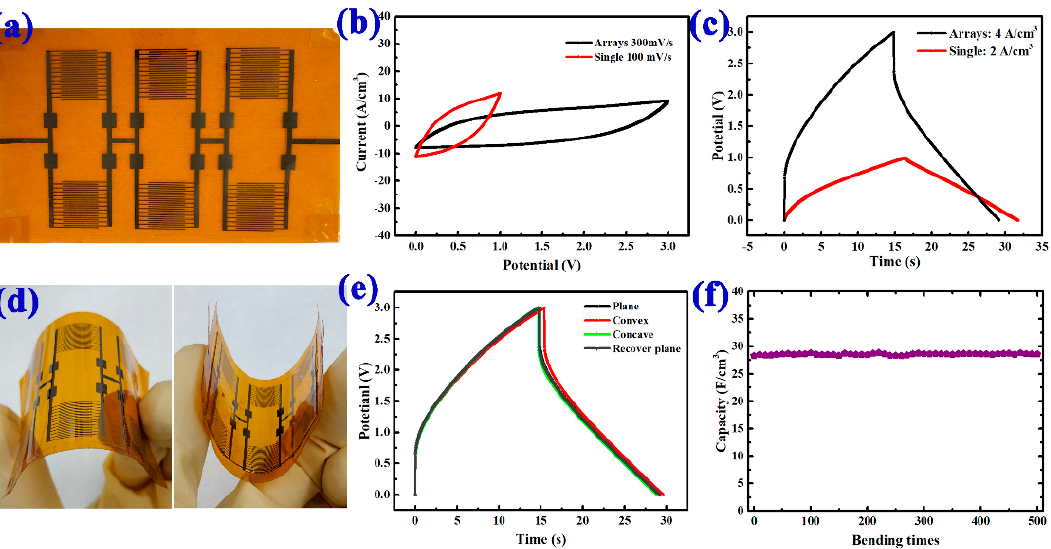
Figure 5. The integrated MSCs system based on six individual devices: ( a ) device position on the substrate; ( b ) CV curves of one MSC and an integrated arrays of six MSCs at scan rates of 100 mV/s and 300 mV/s, respectively; ( c ) galvanostatic CD curves of an array system of one MSC and six MSCs at the currents of 2 A/cm 3 and 4 A/cm 3 , respectively; ( d ) photos of an integrated MSCs system; ( e ) flexibility performance of the integrated MSCs system based on six individual devices at different bending states; ( f ) the capacitance stability of the MSCs during repeated bending-recovery cycles at a galvanostatic current of 4 A/cm 3 .